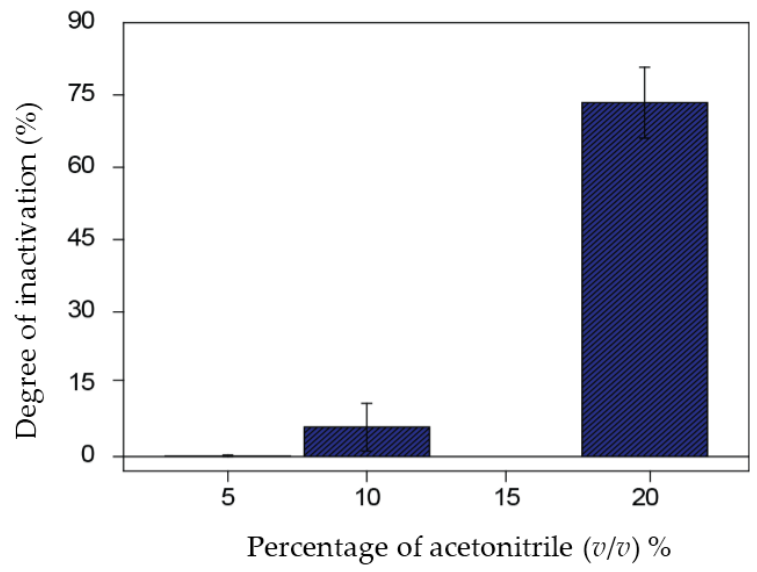
Figure 3. Degree of inactivation recorded for 5 mM butyrylthiocholine in phosphate buffer 0.05 M + KCl 0.1 M pH = 7.4, in the presence of different amounts of acetonitrile ( n = 3).